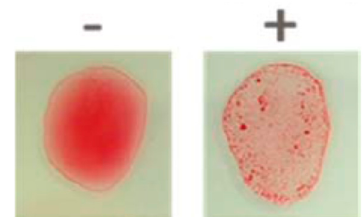
Figure 2. A Bead agglutination assay demonstrating BB200 coupling to colored latex beads (right panel) and detecting K. pneumoniae ST258; while an inactive control antibody does not (left panel).